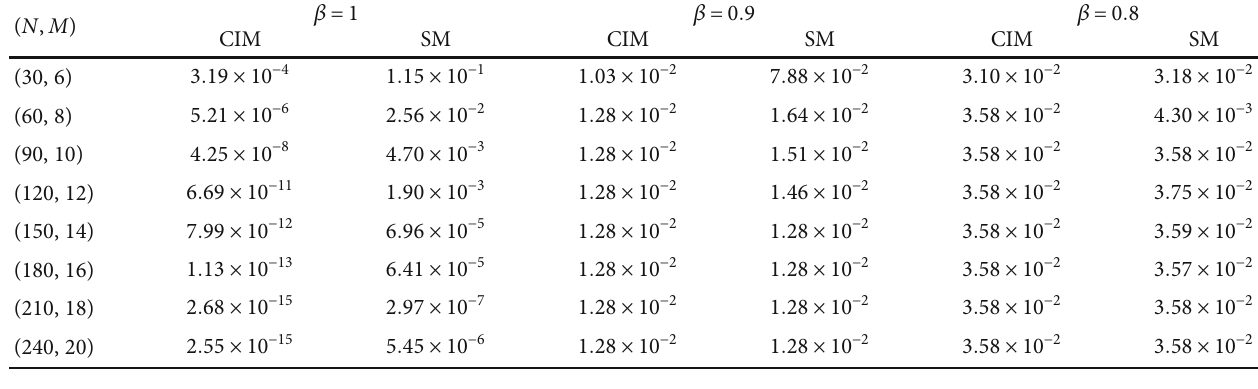
Table 2: For various values of β , N , M the absolute errors corresponding to Problem 1.